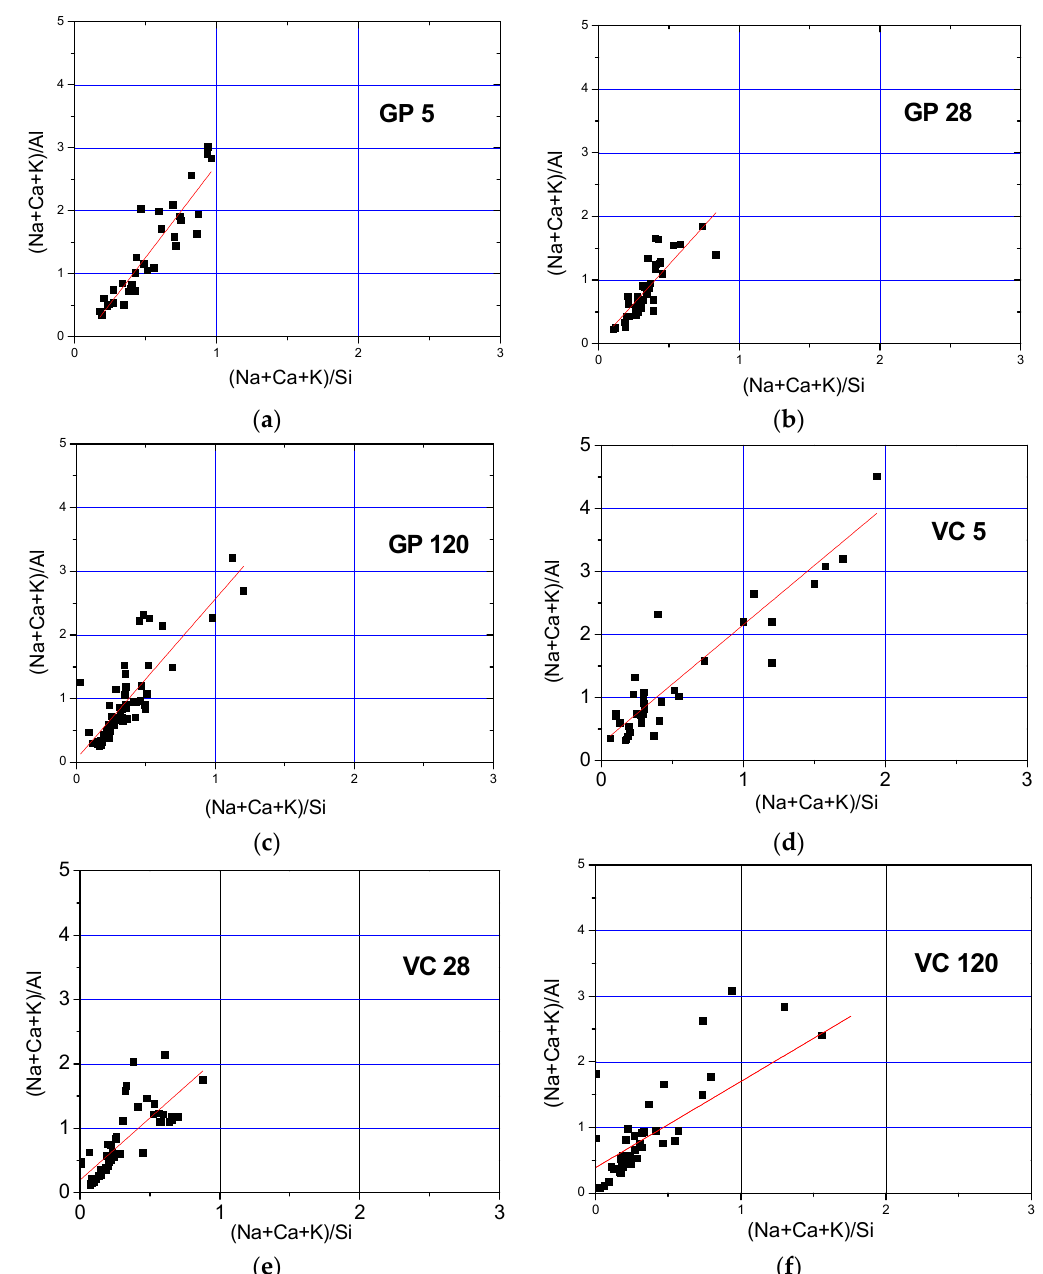
Figure 8. Atomic ratios (Na + Ca + K)/Al vs. (Na + Ca + K)/Si for ( a – c ) GP and ( d – f ) VC aggregates. Table 4. Slope values of the linear curve presented in Figure 8. Sample Slope of the Linear Curve